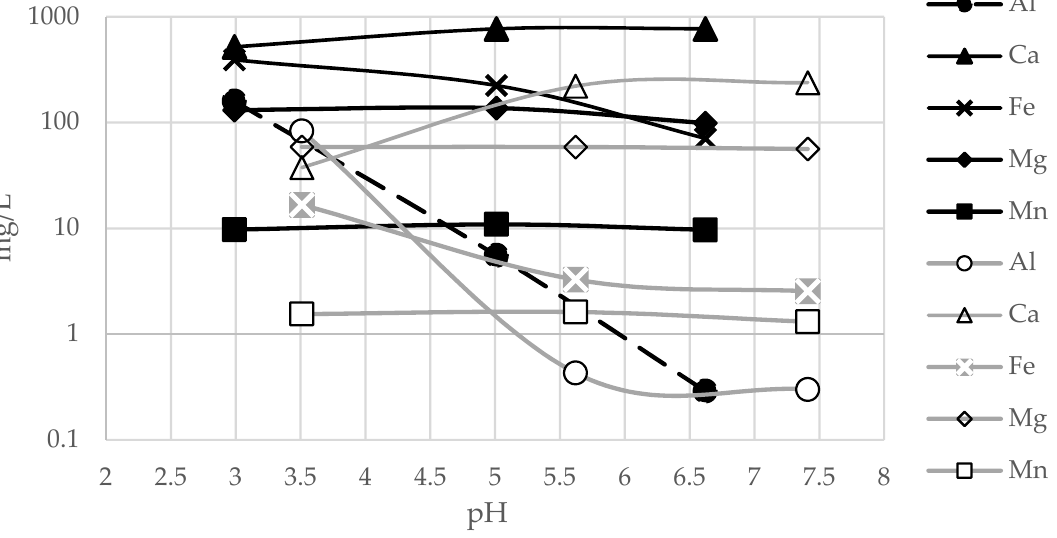
Figure 13. Comparison of some major and minor elements ion concentrations between FA3 (full symbols) and FA4 (empty symbols) from the beginning to the end of buffering.